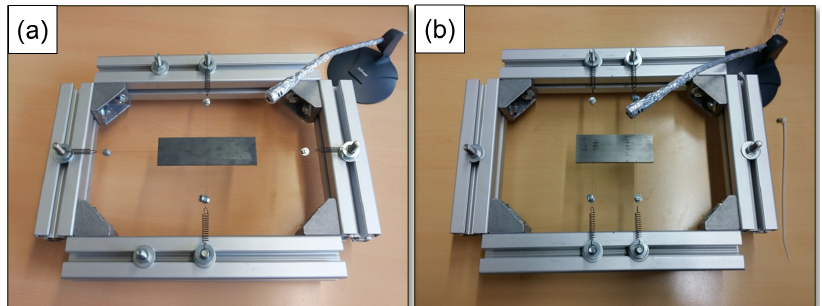
Figure 2. Setup of impulse excitation technique: ( a ) bending oscillation mode for the measurement of the Young’s modulus; ( b ) torsional oscillation mode for the measurement of the shear modulus.